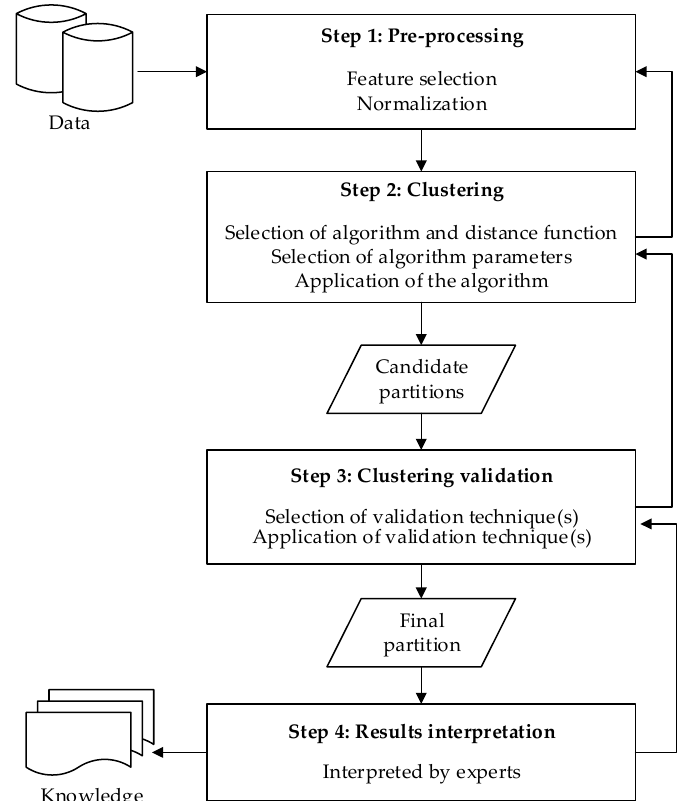
Figure 1. Clustering procedure consists of four steps with a feedback pathway.